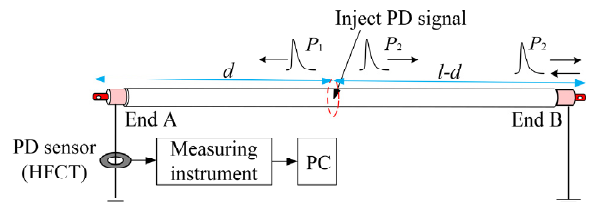
Figure 1. Block diagram of the single-ended PD measuring system.